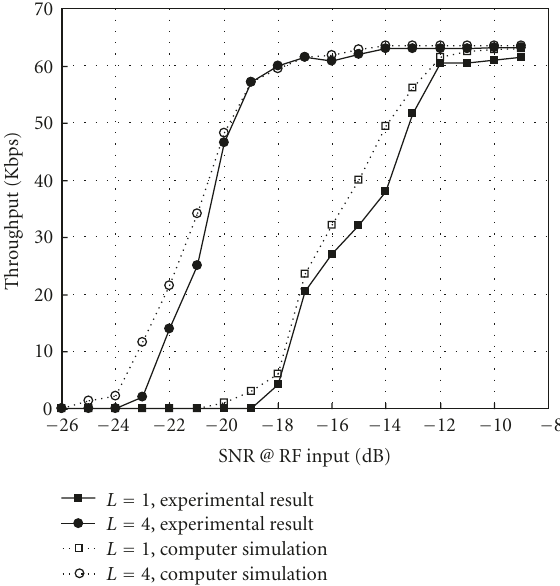
Figure 14: Throughput of implemented SA system obtained by